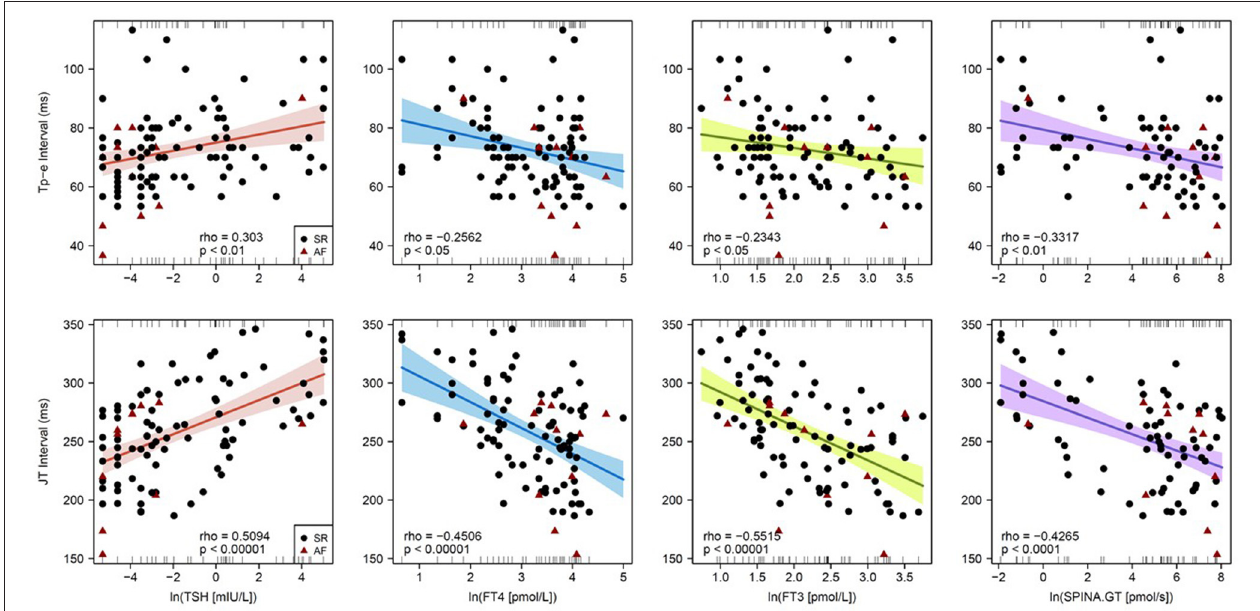
FIGURE 3 | Correlations of Tp-e interval (top) and JT interval (bottom) with endocrine parameters of thyroid homeostasis. Shown are single data points, linear models from Pearson regression with 95% confidence intervals and models of Spearman correlation (in the bottom of each panel).